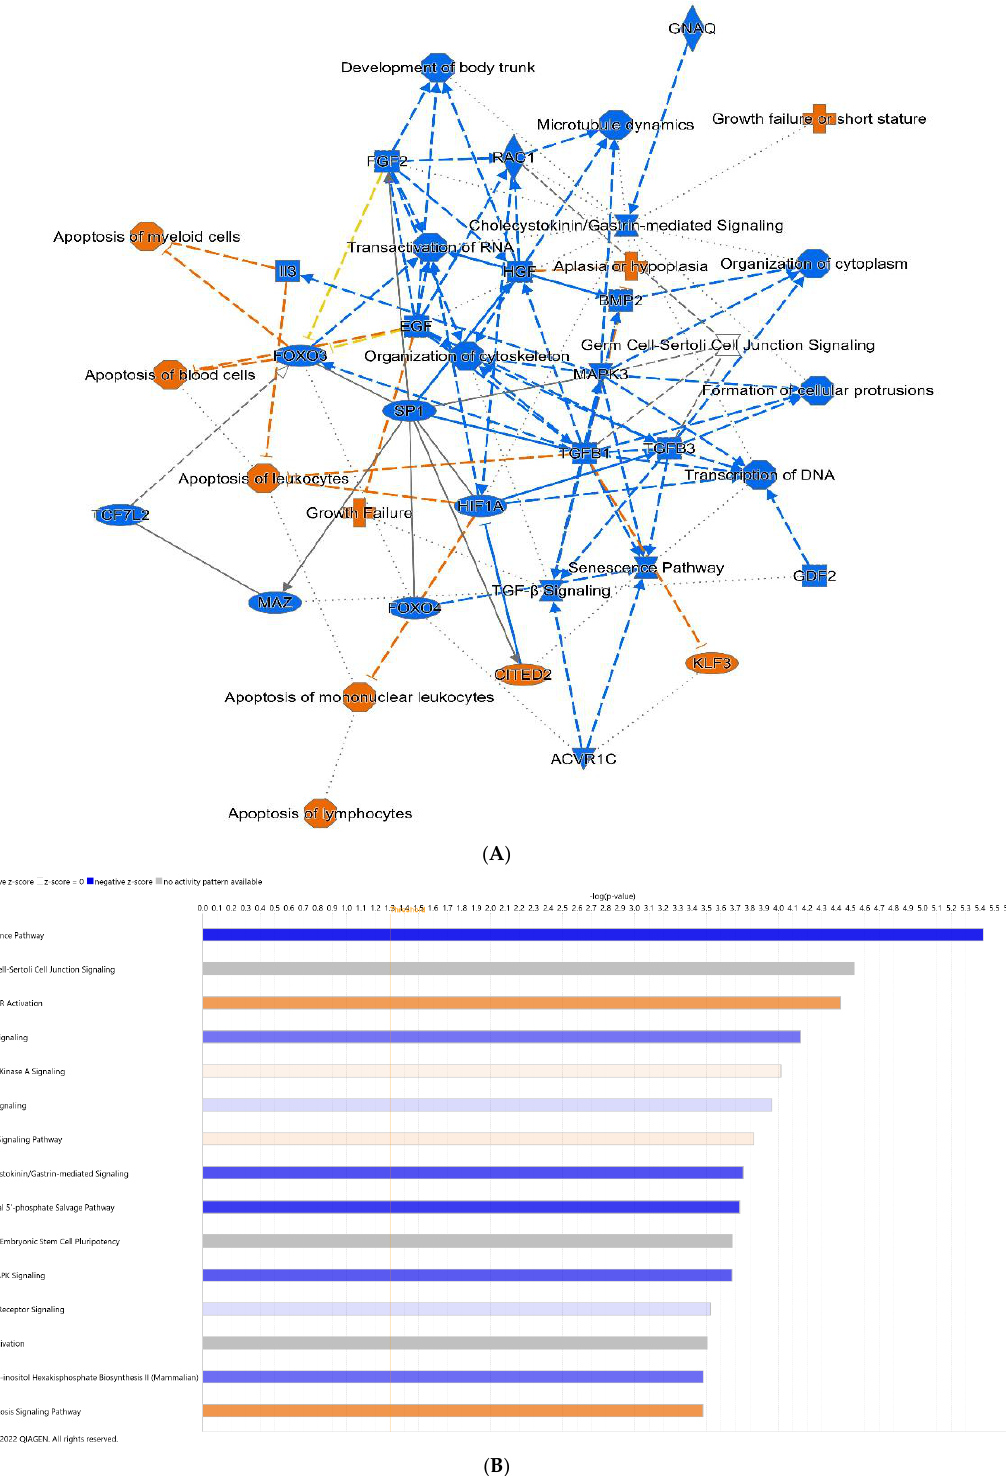
Figure 3. Differential gene expression of terminal ileum of formula pups compared with shams. ( A ) Predicted graphical summary of differentially regulated pathways and genes. ( B ) Top 15 predicted differen- tially regulated canonical pathways. Blue = Z-score < − 2 (downregulation), orange = Z-score > 2 (upregu- lation), scaled to activation level (light = low; dark = high). White = Z-score close to 0. Gray = fewer than four molecules in dataset, resulting in no